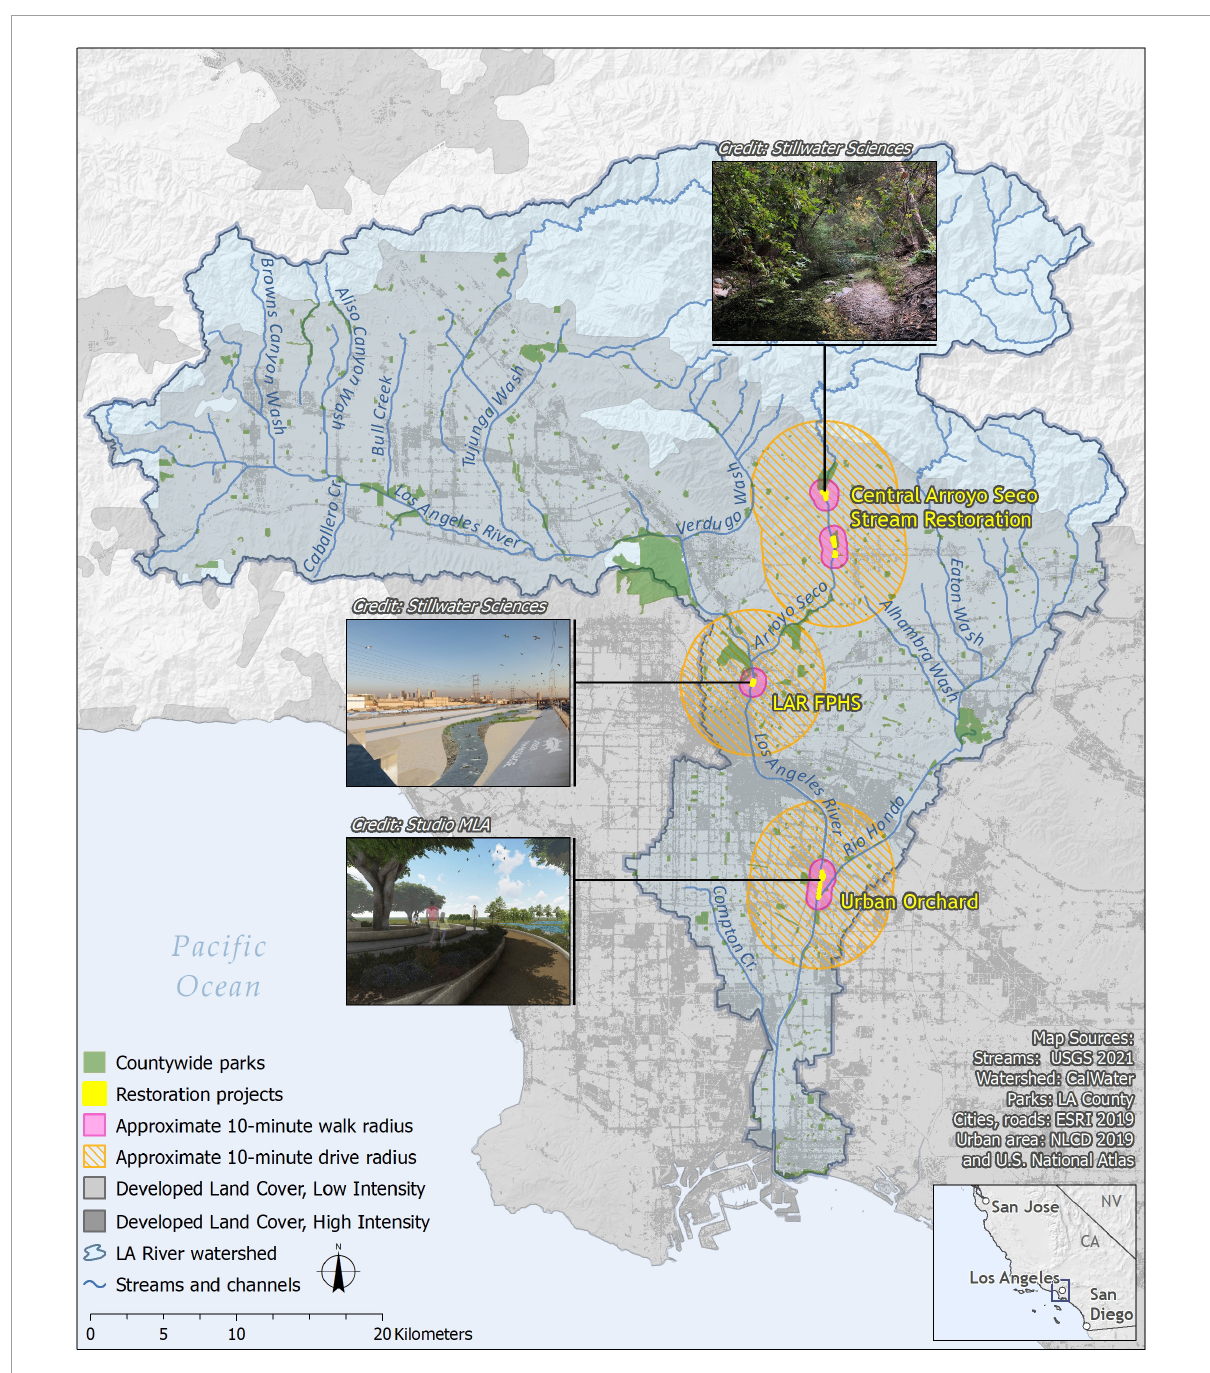
FIGURE2 Conservation projects often improve ecosystem services for people outside of the direct project footprint, leading to further engagement by existing stakeholders and potentially encouraging new stakeholders to realize the value of joining the virtuous cycle to promote future conservation projects. As an example, the LA River Fish Passage and Habitat Structures (LAR FPHS), Central Arroyo Seco Stream Restoration, and Urban Orchard conservation projects in the LA River watershed enhance green space and improve access to nature and recreational opportunities within a 10-min walk (i.e., 0.8 km) or 10-min drive (i.e., 4.8 km) of those projects in a highly urbanized environment. Such enhancements promote stakeholder engagement in the virtuous cycle by those who want to advance these ecosystem services (e.g., local communities, City of LA, Mountains Recreation and Conservation Authority). Please refer Supplementary Figure 1 for a visual comparison of pre-project and current or planned post-project improvements for the three example conservation projects. Magnitude of